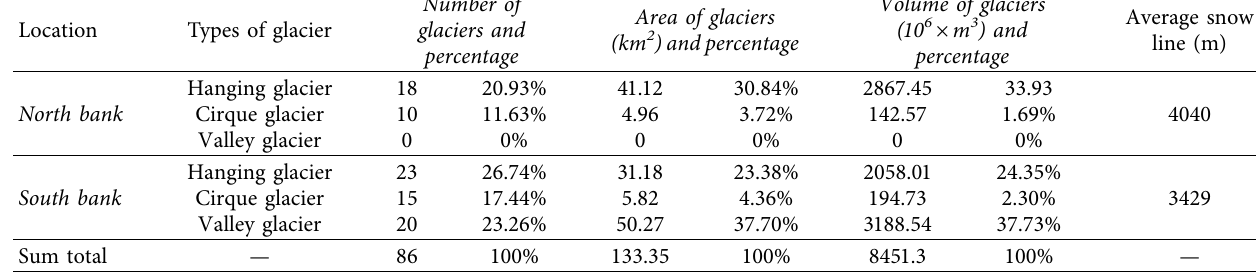
Table 2: Glaciers along the Parlung river from Bomi to Suotong.